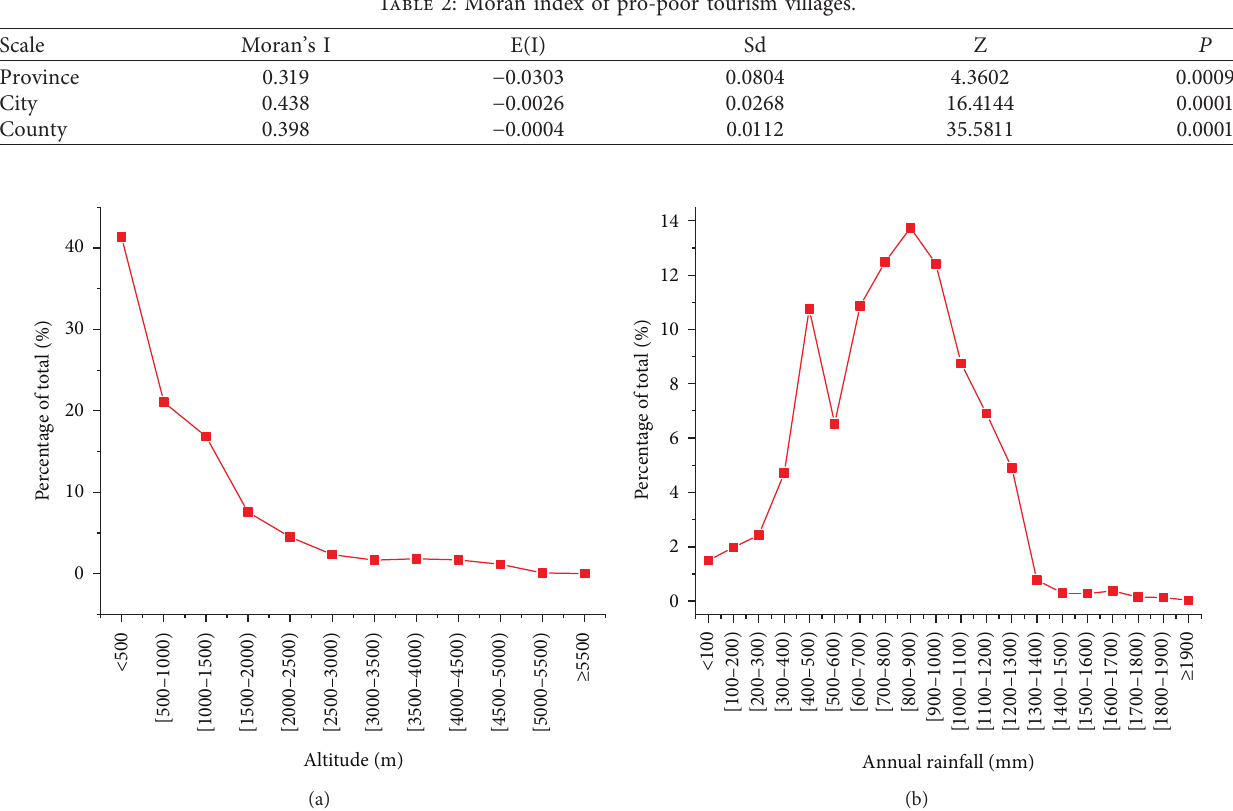
Figure 3: The influence of altitude and annual rainfall on the spatial distribution of tourism poverty alleviation